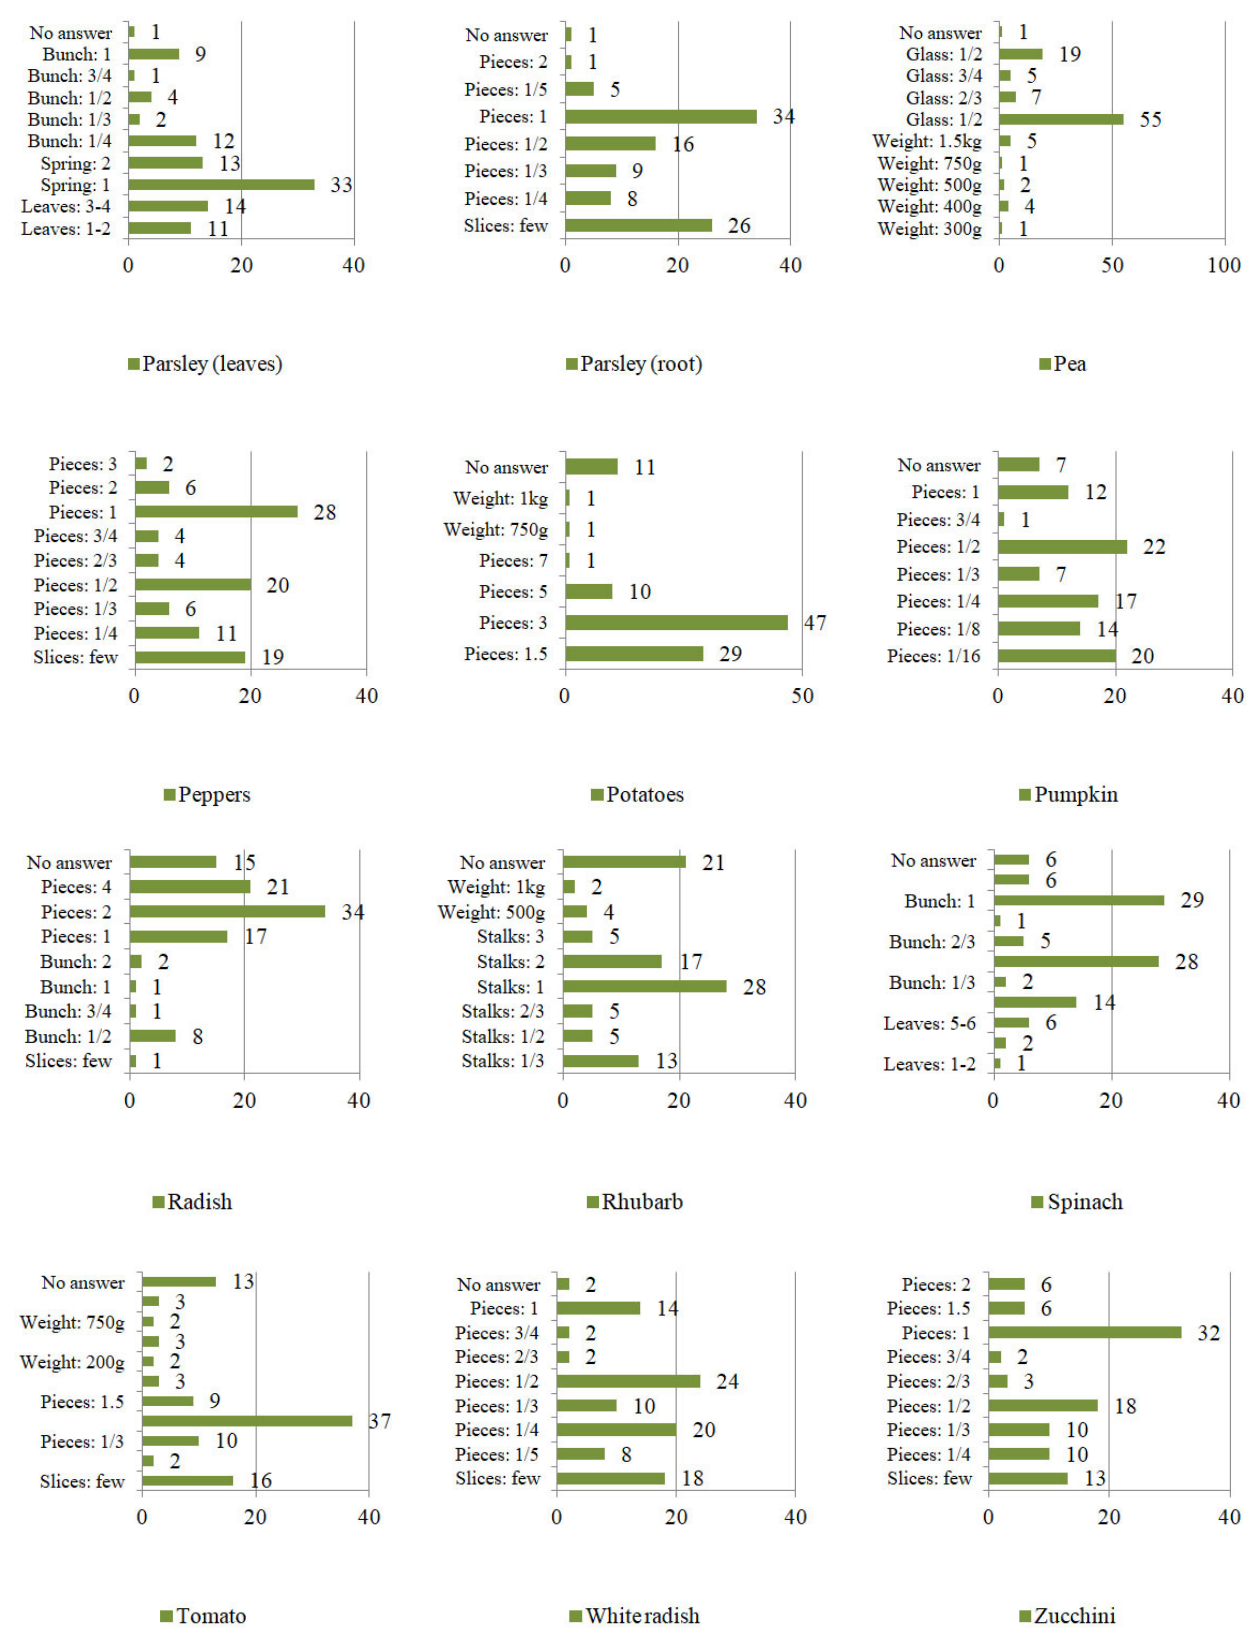
Figure 9. The quantity of vegetables consumed at one sitting by Poles [%] continued.